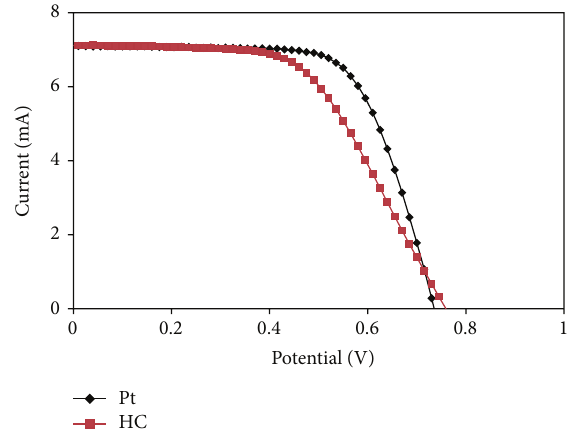
Figure 6: Comparison of 𝐼 - 𝑉 characteristics of DSSCs fabricated with Pt and HC CE under 1 sun illumination (AM 1.5, 100mW/cm 2